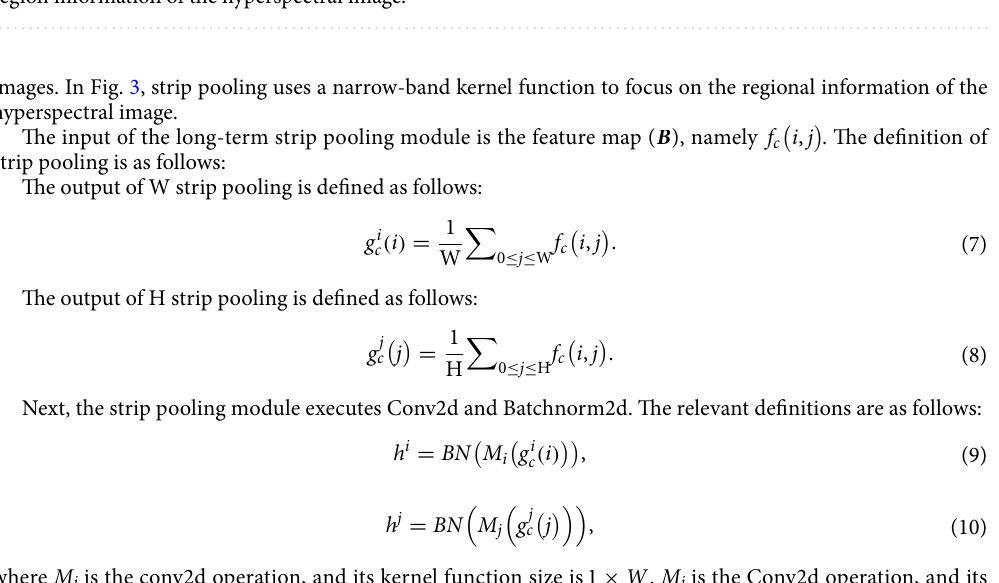
Figure 3. Long-term strip pooling module. The narrowband kernel function is used to expand the network receptive field. Compared with the traditional kernel function, the strip pooling module can better capture the region information of the hyperspectral